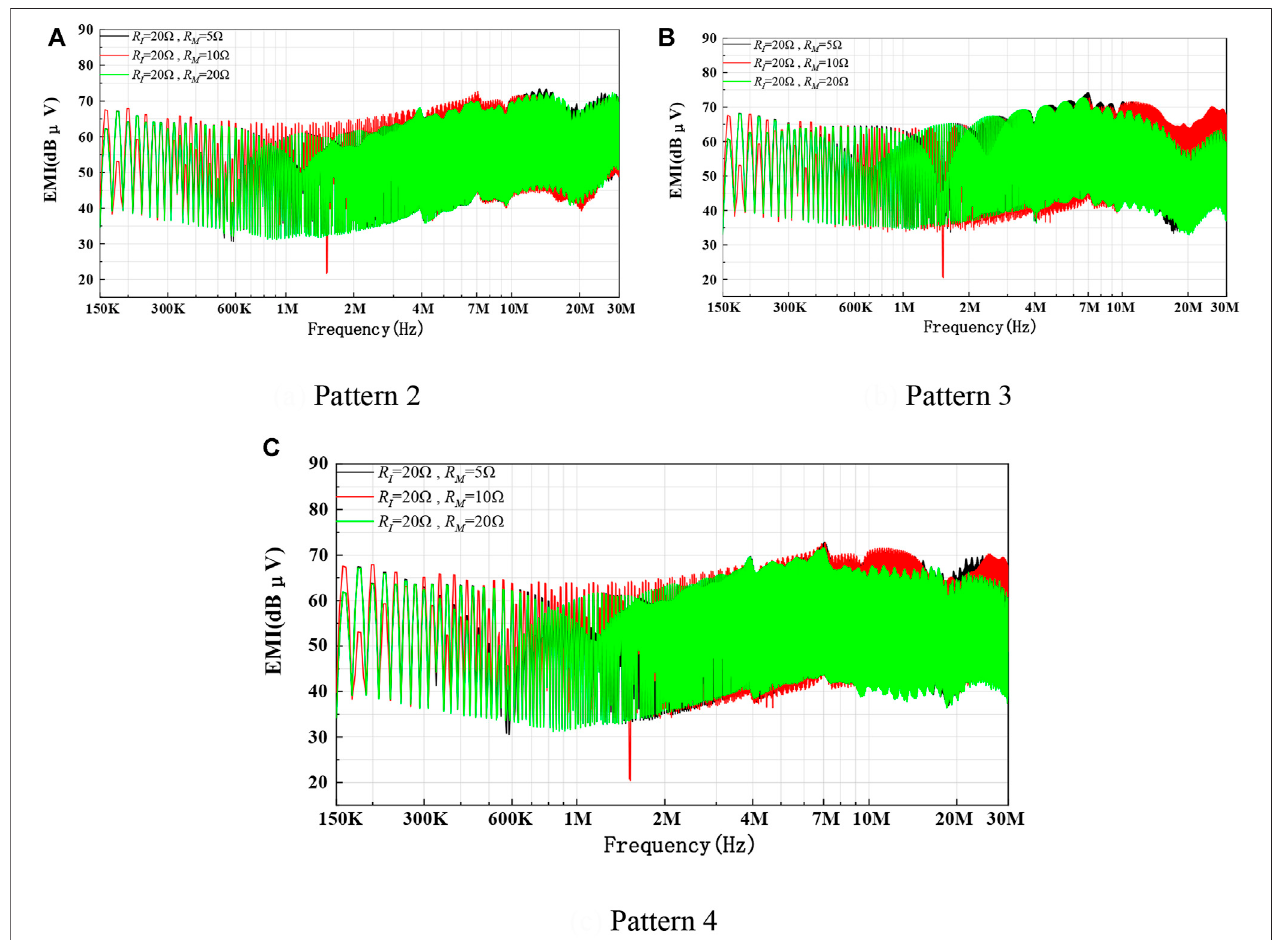
FIGURE 14 | Relationship between the gate resistor and CM EMI noise (changing gate resistor of SiC MOSFET). (A) Pattern 2, (B) pattern 3, and (C) pattern 4.